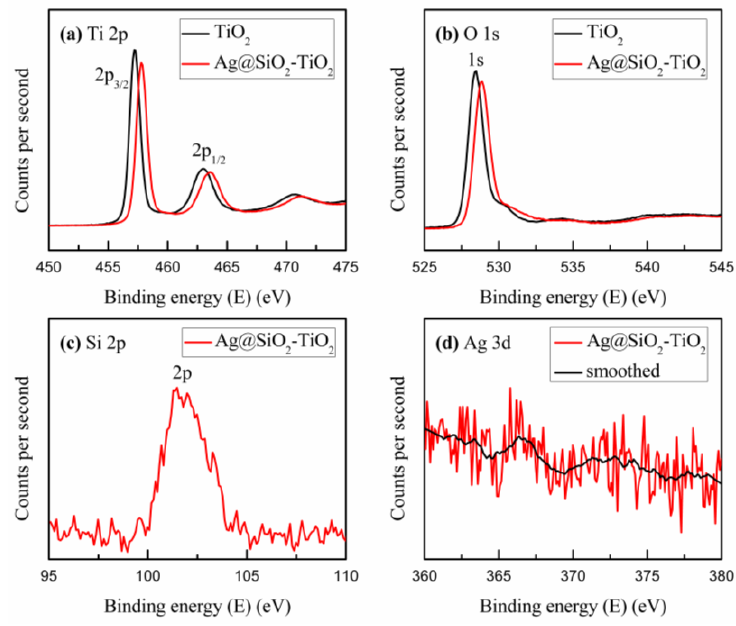
Figure 3. XPS survey spectra acquired from mesoporous TiO 2 and the Ag@SiO 2 -TiO 2 : ( a ) Ti 2p; ( b ) O 1s; ( c ) Si 2p; ( d ) Ag 3d.